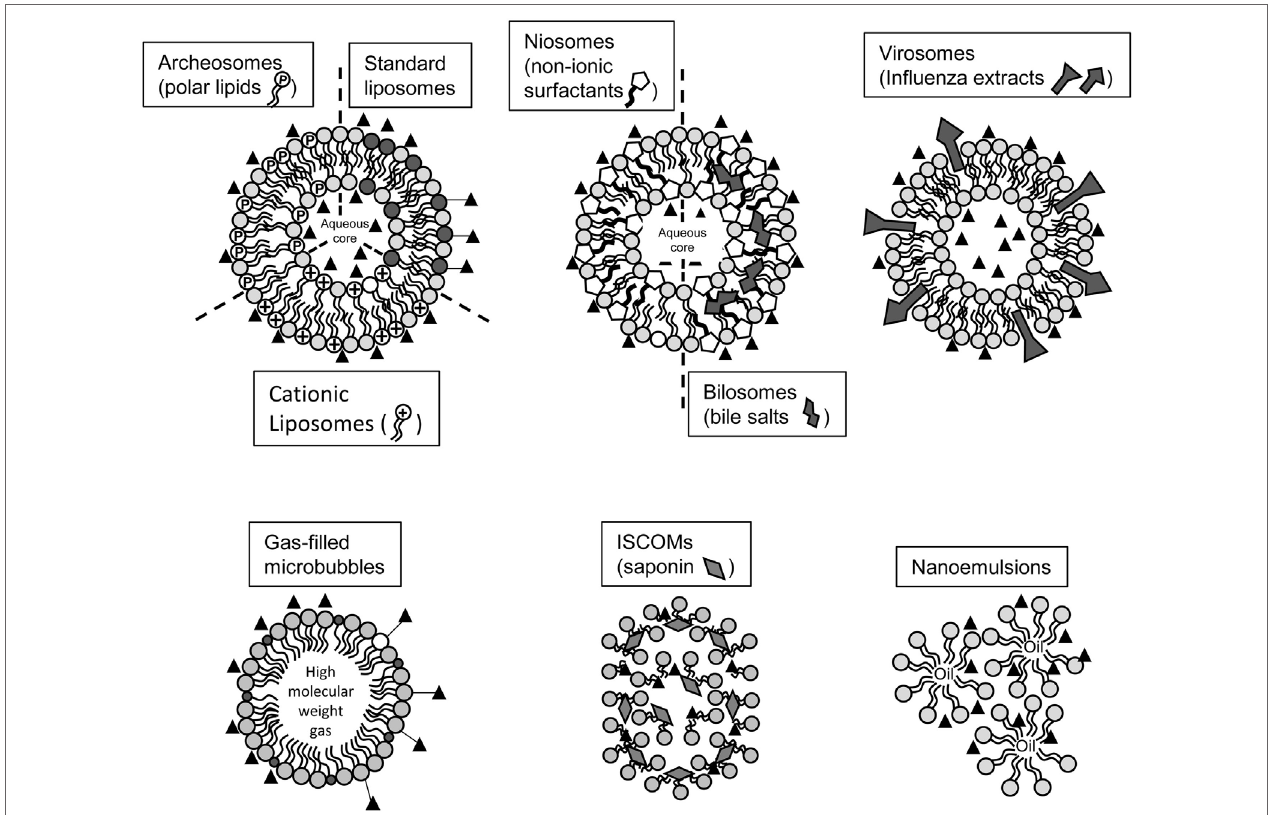
FiGURe 1 | Schematic representation of lipid-based particles evaluated for mucosal vaccination. Liposomes can be tailored to incorporate particular lipids (cationic lipids, polar lipids from Archea), Influenza extracts or non-ionic surfactants in order to improve stability and immunogenicity of vesicles. Other lipid-based structure incorporating saponin, entrapping inert high molecular gas, or composed of emulsions has been developed for vaccination purposes. Black triangles represent Ags. They can be entrapped in aqueous cores, entrapped in hybrophobic parts, associated at the surface of particles through electrostatic interactions, or covalently linked at the surface of particles. Not drawn on